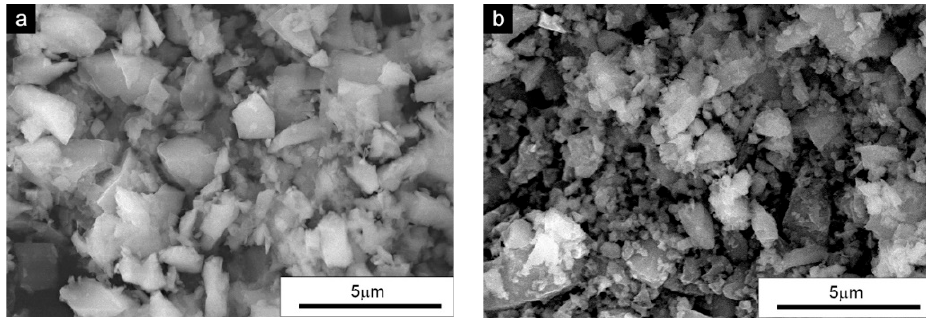
Figure 1. The morphologies of the starting powders: ( a ) α -SiC and ( b ) β -SiC. Sintering was performed by establishing the optimal parameters based on the litera- ture [20] and the authors’ previously researched optimization process. The powders were consolidated using the spark plasma sintering (SPS) method. A sintering temperature of 1900 ◦ C and a sintering time of 30 min were used. The heating and cooling rate of the system was 100 ◦ C/min. Sintering was carried out in a die with a diameter of 20 mm and a punch force of 16 kN, which translated into a pressure of 50 MPa, in vacuum conditions. As a result of this process, cylindrical sinters with d = 20 mm and a height of 5 mm were obtained. Before further testing, the graphite layer that remained on the surface of the obtained samples after taking them out of the matrix had to be removed. The share of ingredients in the initial mixture and all variants of the prepared powder mixtures are presented in Table 1. Table 1. Weight fractions of the prepared powder mixtures with